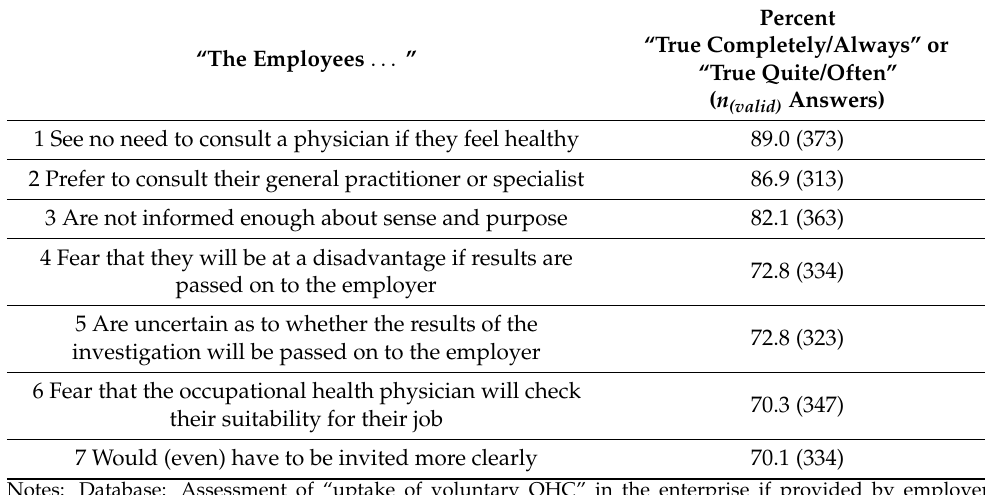
Table 5. Possible reasons for lack of uptake of voluntary occupational health care (assessed by of occupational health physicians; ordered according to frequency of